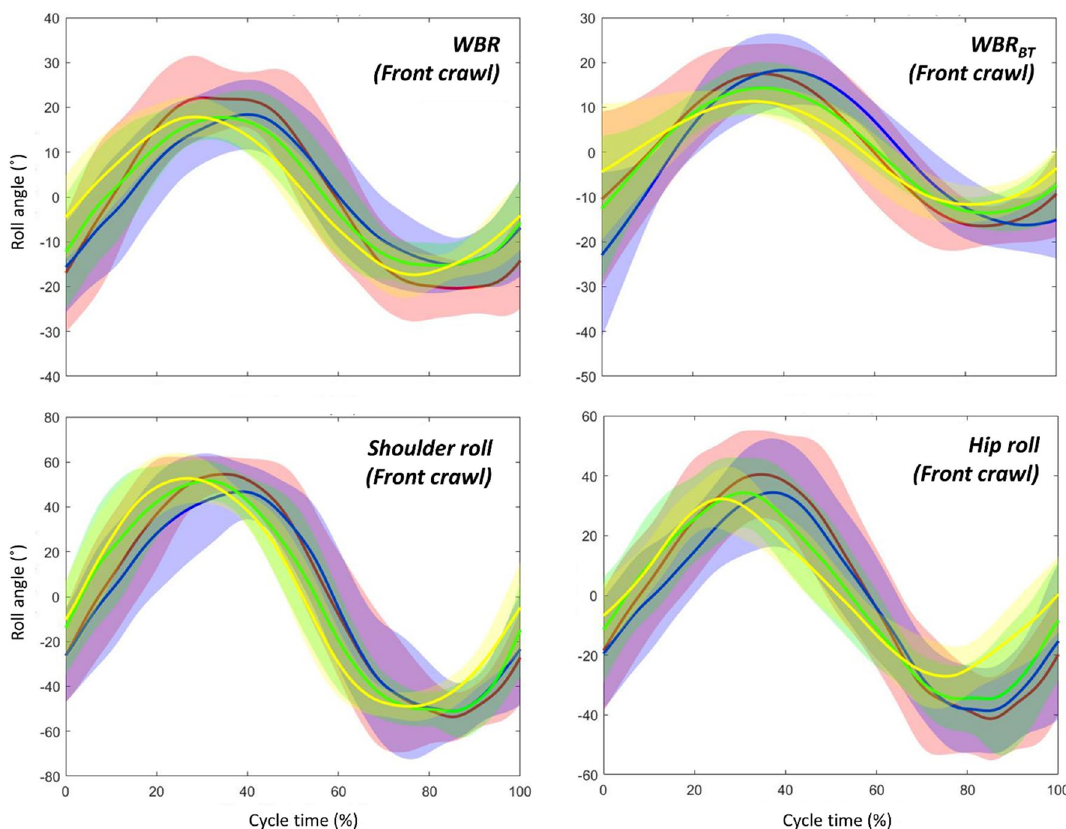
Figure 5. Time-series data (averaged among all participants) of the whole-body roll ( WBR ), whole-body roll due to the buoyant torque ( WBR BT ), shoulder roll, and hip roll in front crawl. Red, blue, green, and yellow lines show the averaged data at 83, 88, 93, and 100% of the maximal velocity trial, respectively, and the shaded areas shows the inter-participant standard by reducing the entry phase (from the hand entry to the water until the start of its backward motion) duration. Swimmers reduce the entry phase duration by more than 10% from a distance to a sprint pace 25 , whereas they only show a 3% change in the entry phase duration in backstroke with a corresponding pace change 38 , meaning that the transition of the coordination mode is less evident in backstroke. In sprint front crawl, the maximum shoulder roll peak is achieved when swimmers transit their motion from the entry phase to the subsequent arm pull phase 41 . This means that swimmers drive their shoulder downward throughout the entry phase, suggesting that the duration of this phase relative to the stroke cycle time should be related to the maximum shoulder roll peak amplitude and timing. Indeed, a change in the entry phase relative duration tends to match that in the shoul- der roll amplitude in a 200 m front crawl 6 . As an example from the present study, Fig. 7 shows side-view stick figures of front crawl and backstroke at the time of the maximum hip roll in one swimmer. This example clearly exhibits the change in the position of upper- and lower-limbs in front crawl when the velocity was increased, whereas the limb position in backstroke was almost identical despite the change in the velocity. Nevertheless, there is currently no direct evidence supporting the relationship between the roll amplitude and the entry phase duration, which would be of interest to investigate in further studies. The present study was the first to investigate body roll characteristics in backstroke and compared the inves- tigated kinematics with front crawl, which provided insight into the body of alternating swimming technique knowledge. However, it should be noted that the outcomes presented in the current study should not be gen- eralised for all populations. The buoyant torque is highly related to the anthropometry and the duration of upper-limbs being above the water in relation to the cycle time. This means that swimmers who have different anthropometric and kinematic characteristics from the participants of the current study, such as female swim- mers and young swimmers, might show different results. Therefore, a wider range of groups should be tested in future studies. Furthermore, the analyses conducted in the current study contained some assumptions such as no wave around the body and the no effect of the segmental angular momentum around its long axis (apart from the trunk). Therefore, the absolute WBR and WBR BT amplitude and timing likely contain some systematic errors. However, our focus of the study was to quantify the effect of swimming intensity on body roll and differ- ences between front crawl and backstroke, rather than establishing the absolute WBR and WBR BT values. As the same assumptions were applied to all trials and both techniques, the effect of the probable systematic errors on the main findings of the current study should be small.